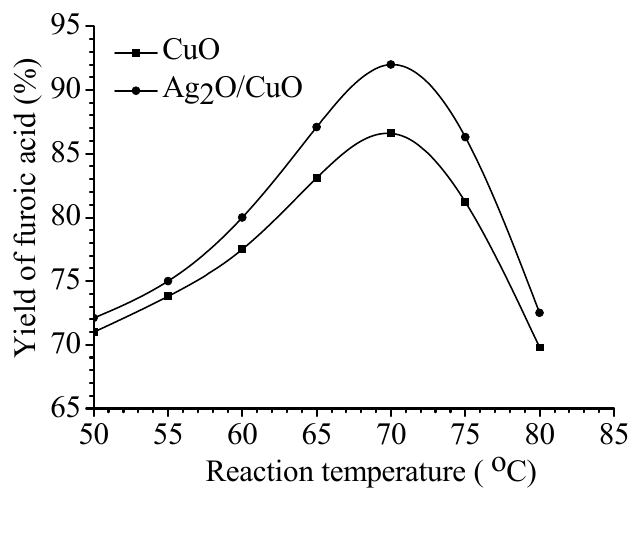
Figure 1. Effect of reaction temperature on furoic acid